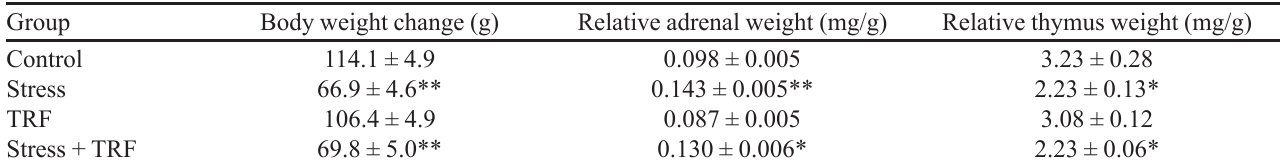
TABLE I - Body weight change and relative weight of the adrenal and thymus glands Group